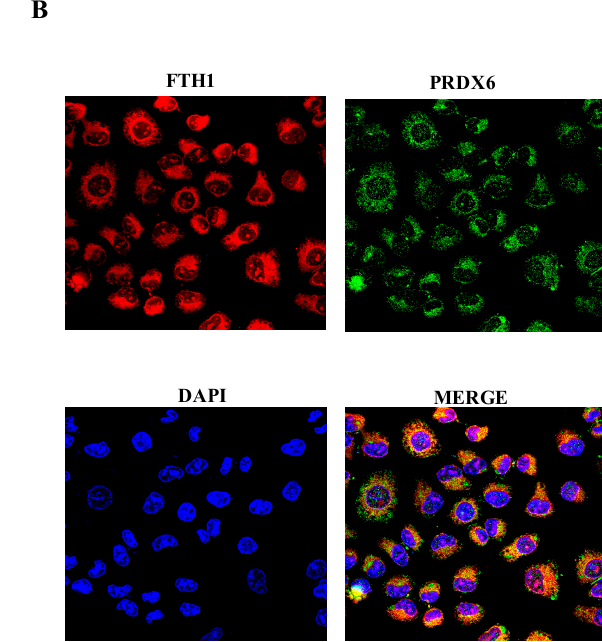
Figure 3. Co-IP and colocalization analysis of the interaction between FTH1 and PRDX6. ( A ) NCI-H460 cells were transfected with Flag-FTH1 or a control vector (3x-Flag). Cell lysates were immunoprecipitated with anti-Flag M2 resin and then analyzed by immunoblotting with anti-PRDX6 and anti-Flag antibodies. ( B ) NCI-H460 cells were grown on a coverslip, fixed with 4% paraformaldehyde and processed for double-label immunofluorescence with anti-FTH1 antibody and anti-PRDX6 antibody. Images were collected using confocal microscopy system (40 × ). Representative data from one of three experiments.